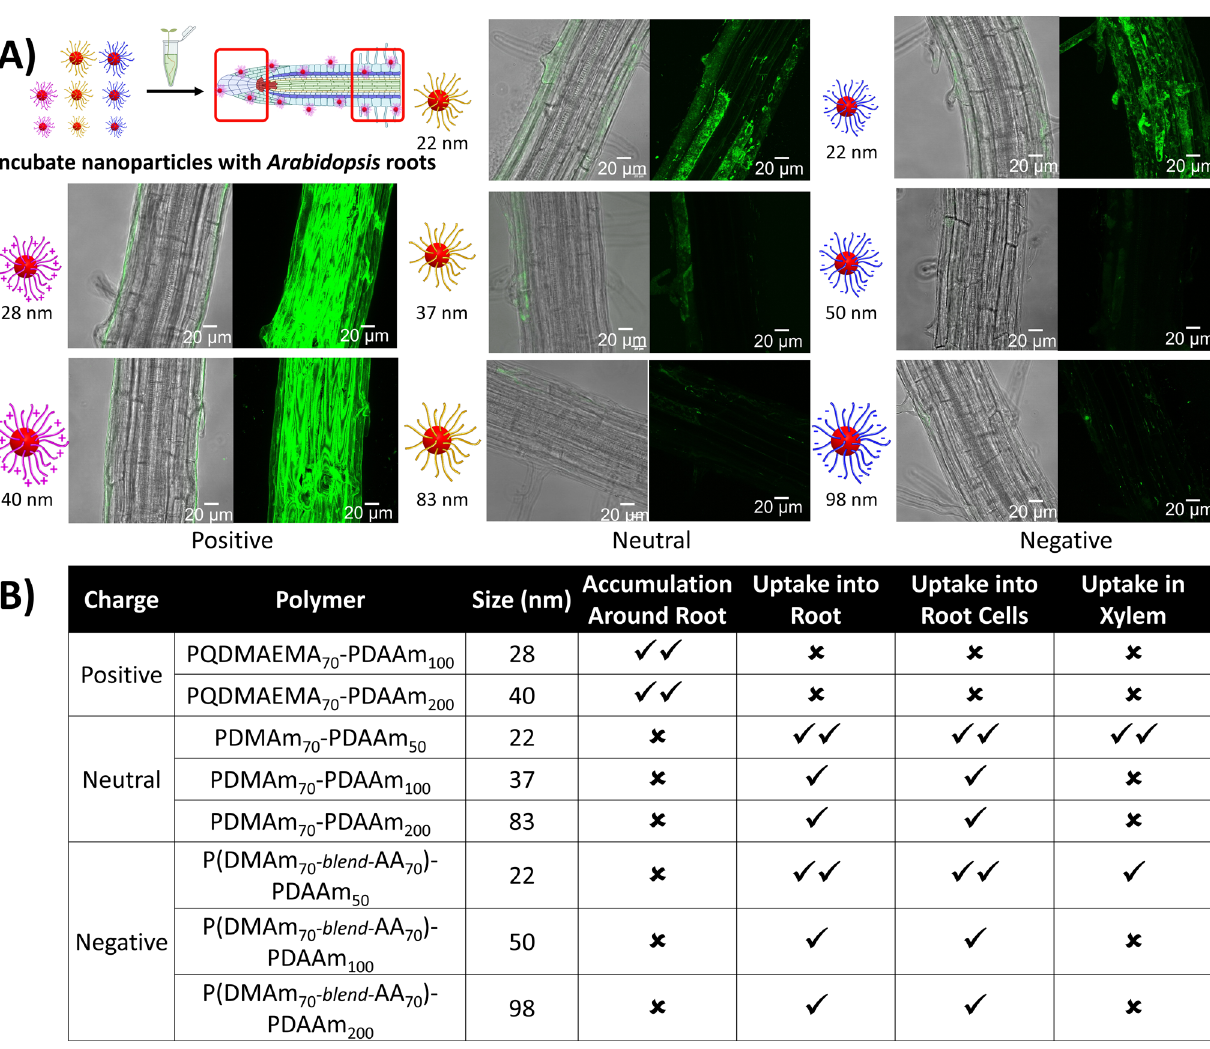
were evaluated under a ZEISS 880 LSM. Maximum Z projections in 488nm laser channel were analysed alongside the Z-slices and merged with bright fi eld images using ImageJ software. Scale bar=20 μ m. The images are representatives of experimental replicates ( n =3). Part of this fi gure was created with